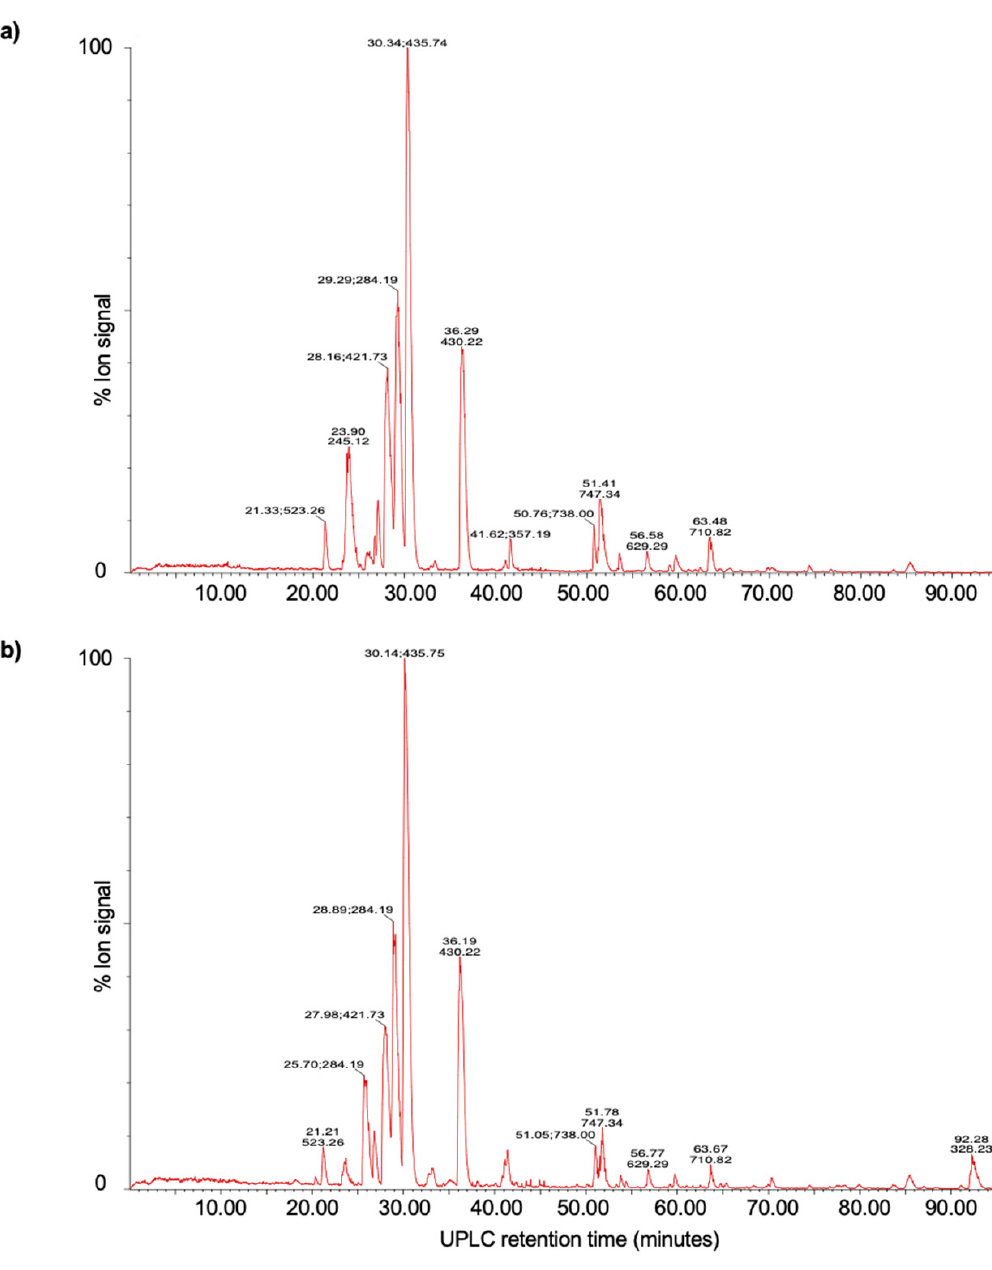
Figure 3. UPLC-MS of the SDS-PAGE gel bands with lytic activity, ( a ) protein with an apparent molecular mass of 107 kDa, and ( b ) 24 kDa. The masses in the spectra are protonated masses of the most prominent detected compounds. Eight peptides were identified in the 24 kDa lytic band via the UPLC-MS analysis. Such peptides showed similarities with 12% of coverage with a protein fragment containing Table 5. Peptides obtained from the SDS-PAGE gel bands with lytic activity by UPLC-MS, ( a ) protein the GA (protein G-related Albumin-binding) domain within the genomic sequence of L. sali- with an apparent molecular mass of 107 kDa and ( b ) 24 kDa . varius with aminopeptidase molecular function (UniProt accession